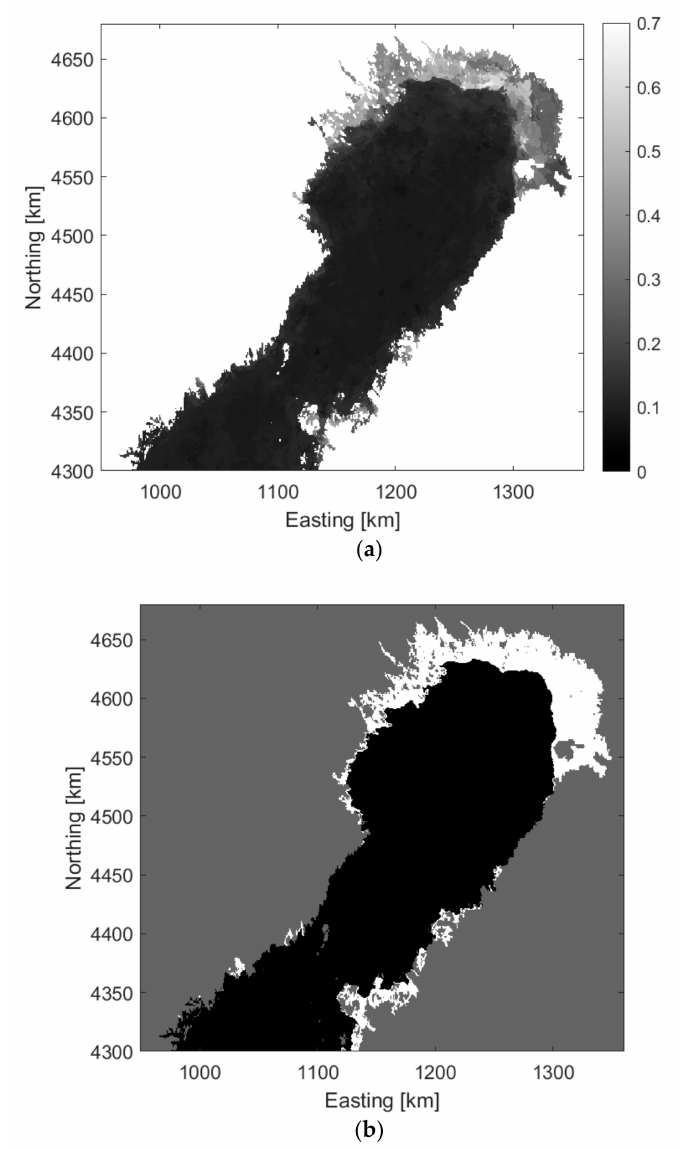
Figure 6. ( a ) Temporal second smallest value of cross-correlation of the SAR mosaics at HH-polarization for a 15 day period ending on 5 March 2020. The cross-correlation is computed between SAR mosaics of two adjacent days. At each pixel location, the second smallest cross-correlation during the 15 day period is shown. ( b ) Landfast ice extent is estimated based on thresholding of the second smallest value of cross-correlation. In addition, morphological filtering is applied to smooth the LFI